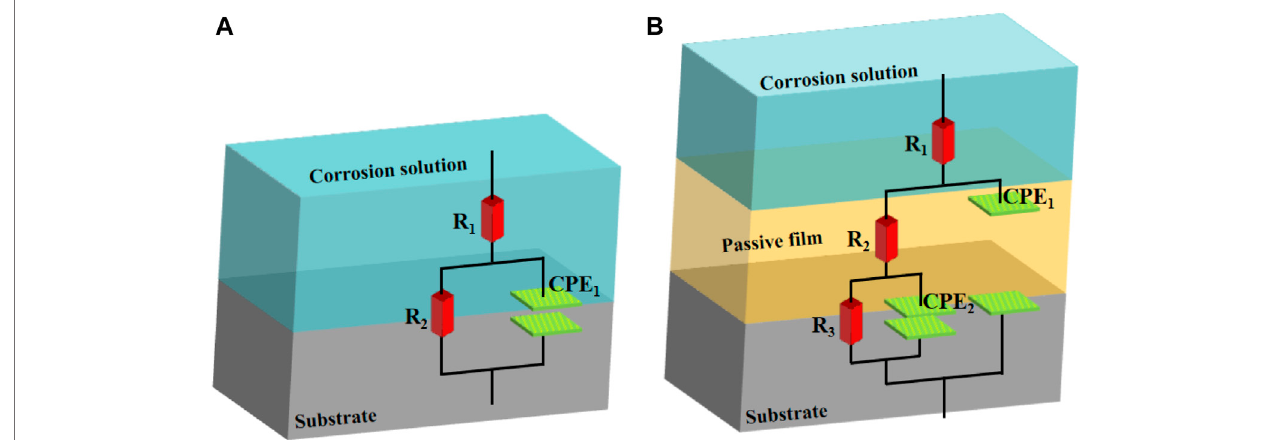
FIGURE 3 | Equivalent circuit diagram (A) single time constant (B) double time constant.